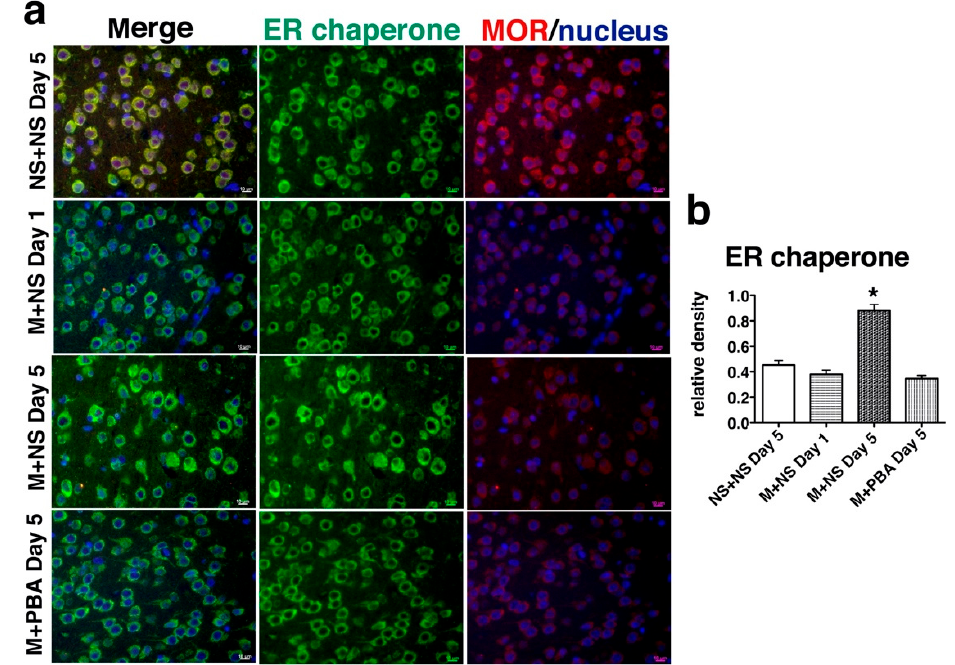
Figure 5. ER chaperone expression was enhanced in MOR-expressing neuronal cells in the PAG matter after repeated morphine administration. ( a ) Mice received intraperitoneal morphine (M, 20 mg/kg) and oral saline (NS, 300 µL) or 4-phenylbutyrate (PBA; 1.0 mg/kg) twice a day for 5 days. After the first injection on day 1 and the tenth injection on day 5, the brains were sectioned and double-immunostained with an anti-MOR antiserum (red) and anti-BiP monoclonal antibody (ER chaperone, green). Nuclei were stained with Hoechst 33258 (blue). Scale bars represent 10 µm. ( b ) MOR-immunopositive neurons in the PAG matter of mice that developed morphine tolerance after the tenth injection on day 5 (M + NS day 5) showed enhanced BiP expression compared with other mice. Densitometry was assessed in 10 cells in each group. * p < 0.001, one-way analysis of variance with Bonferroni post-hoc test.